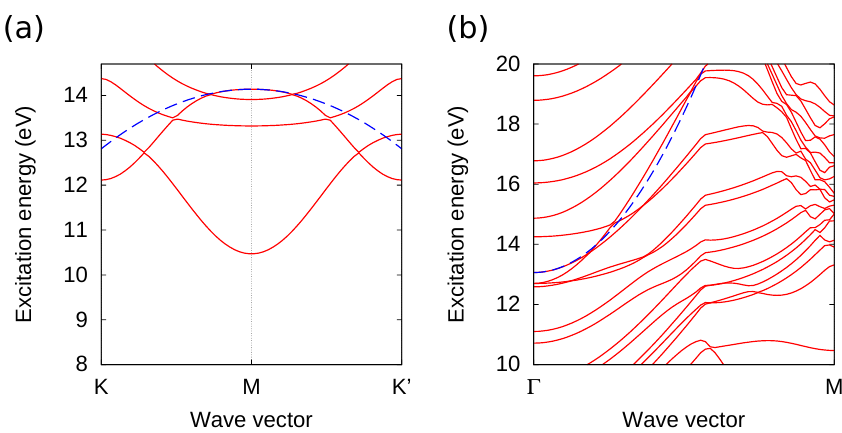
Figure 3. Red lines show vertical transition energies from the highest valence band to conduction bands in monolayer h -BN around ( a ) the M point and ( b ) the Γ point. The transition energies are computed by the difference of the Kohn–Sham eigenenergies of the highest valence band and conduction bands, − (cid:101) (cid:101) , corresponding to excitations in the independent particle approximation. Blue lines show the c (cid:126) k v (cid:126) k parabolic fits of specific